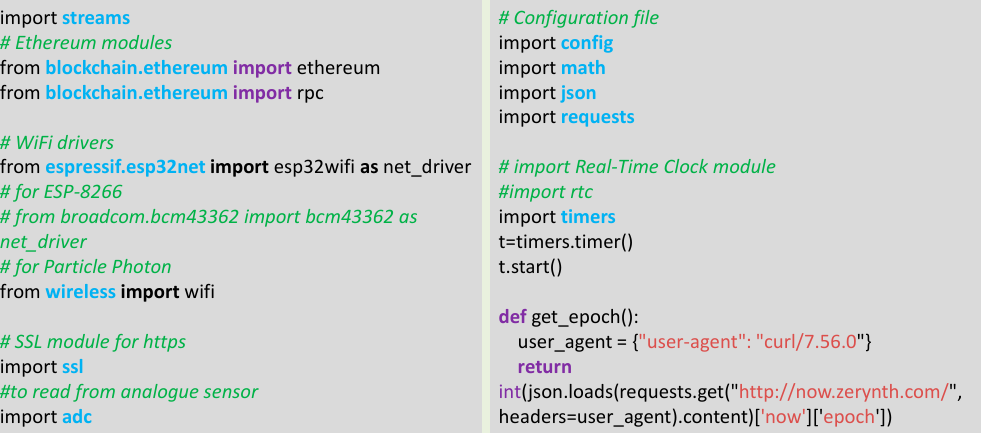
Figure 4. The Construction flowchart of Smart Contract .